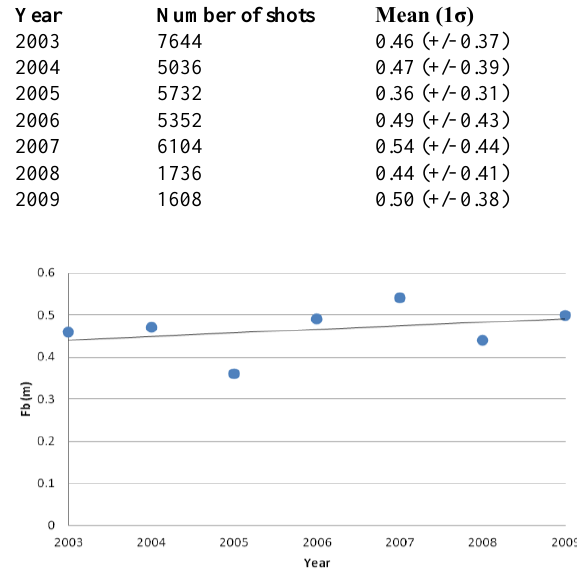
Figure 5. Mean freeboard (Fb) for the whole study area.